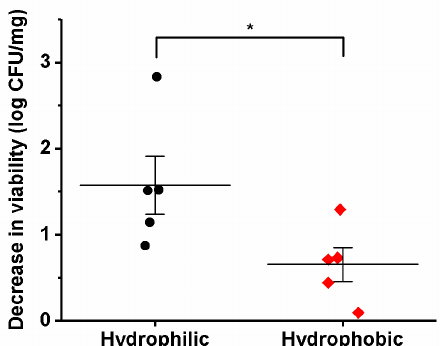
Figure 4. Bacterial cells with a lower hydrophobicity ( < 40%, hydrophilic, black circles) showed larger decreases in viability after incorporation into nanofibers, in comparison to bacterial cells with a higher hydrophobicity ( > 70%, hydrophobic, red diamonds). The horizontal lines indicate the means. *, p < 0.05 (Mann–Whitney tests).